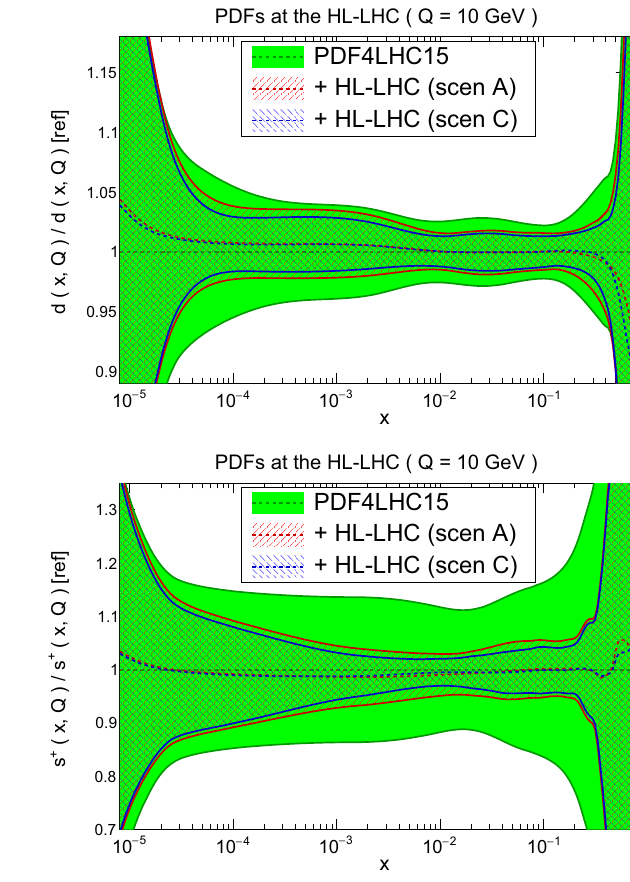
Fig. 17 Comparison of the PDF4LHC15 set with the HL–LHC pro- filed set in scenarios A and C, defined in Table 2. We show the gluon, down quark, up anti–quark, and total strangeness at Q = 10 GeV, nor-